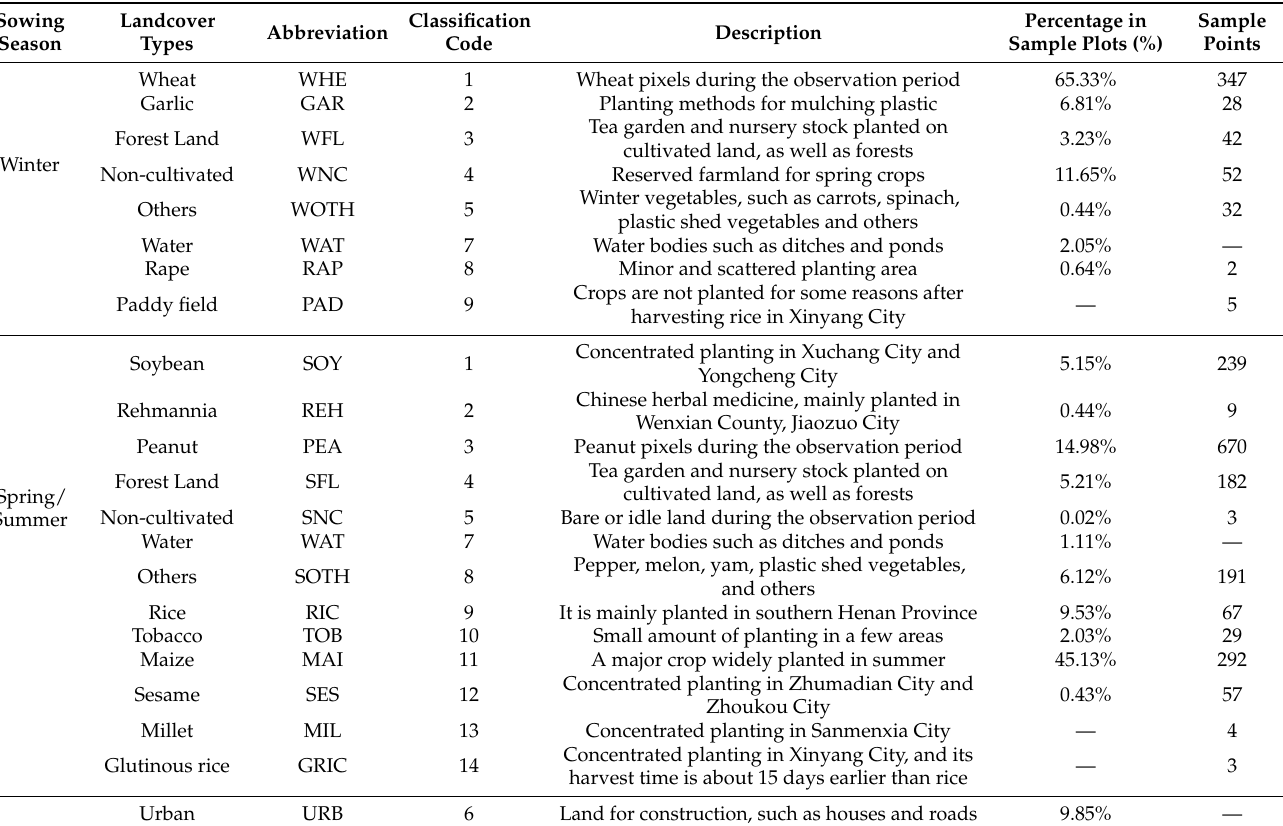
Table 2. Ground measured data for the sample plots and points in this